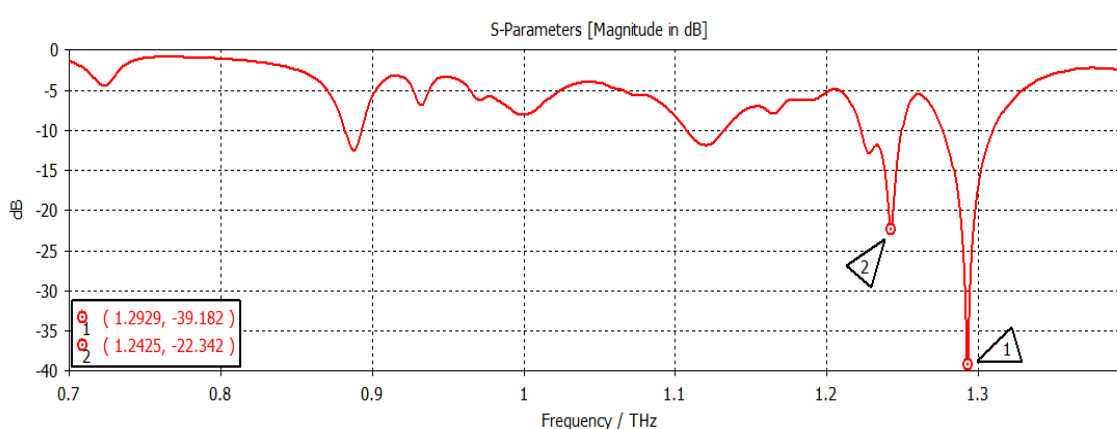
Figure 12. w 1 = 50 µm and z 1 = 300 µm.